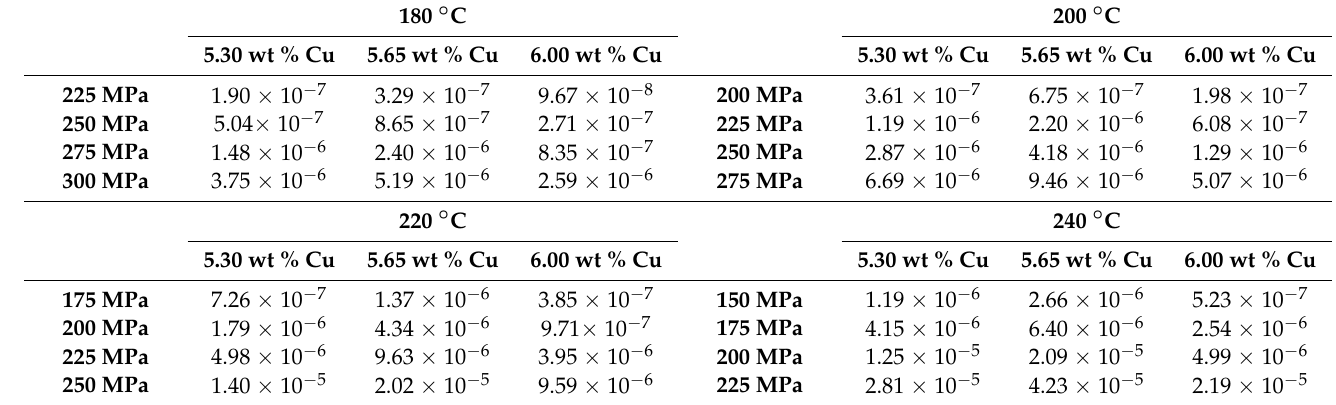
Table 3. Steady creep rates (s − 1 ) of three Al–Cu–Mg–Ag alloys under different creep